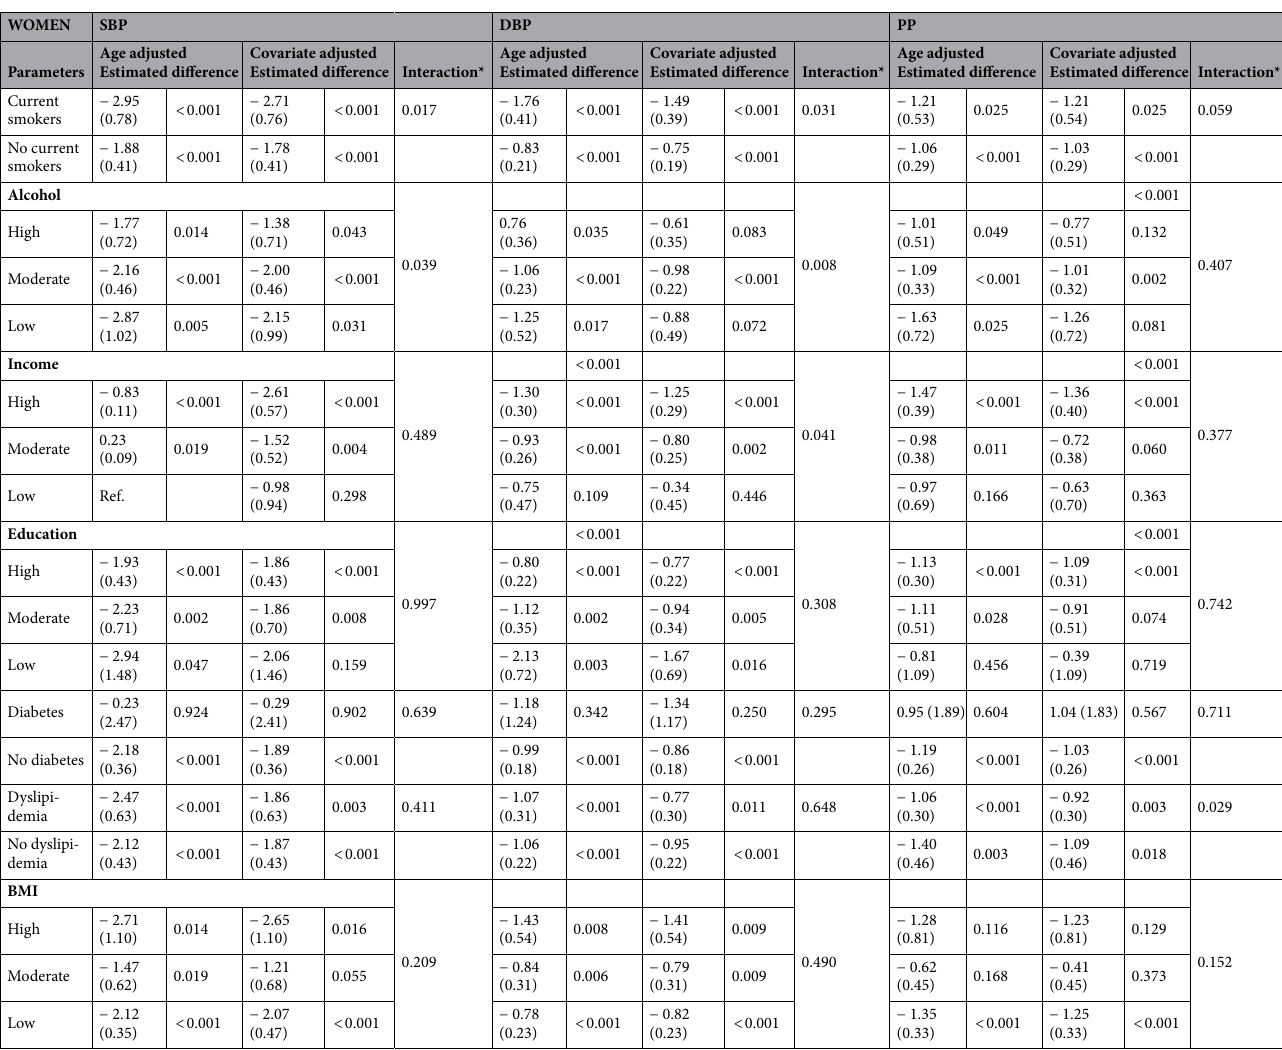
Table 4. Associations of heavy cannabis users (Referent group is never user of cannabis) and blood pressure levels among women, using linear regression models. SBP systolic blood pressure, DBP diastolic blood pressure, PP pulse pressure, BMI body mass index. *Interaction were performed among covariate adjusted models. Covariates adjusted estimated differences were adjusted for age, education, income level, tobacco habits, alcohol consumption, BMI categories, dyslipidemia, and diabetes, except for the stratified